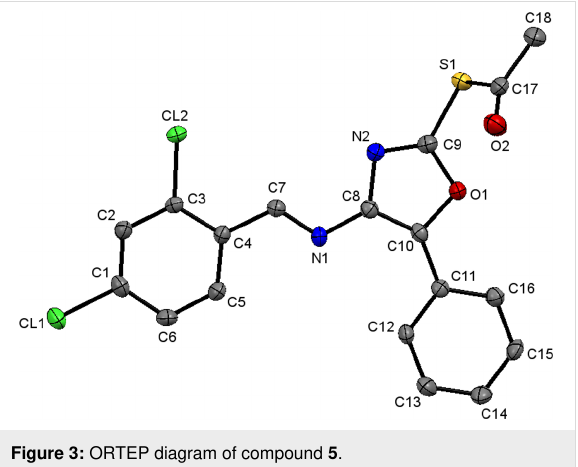
Figure 3: ORTEP diagram of compound 5